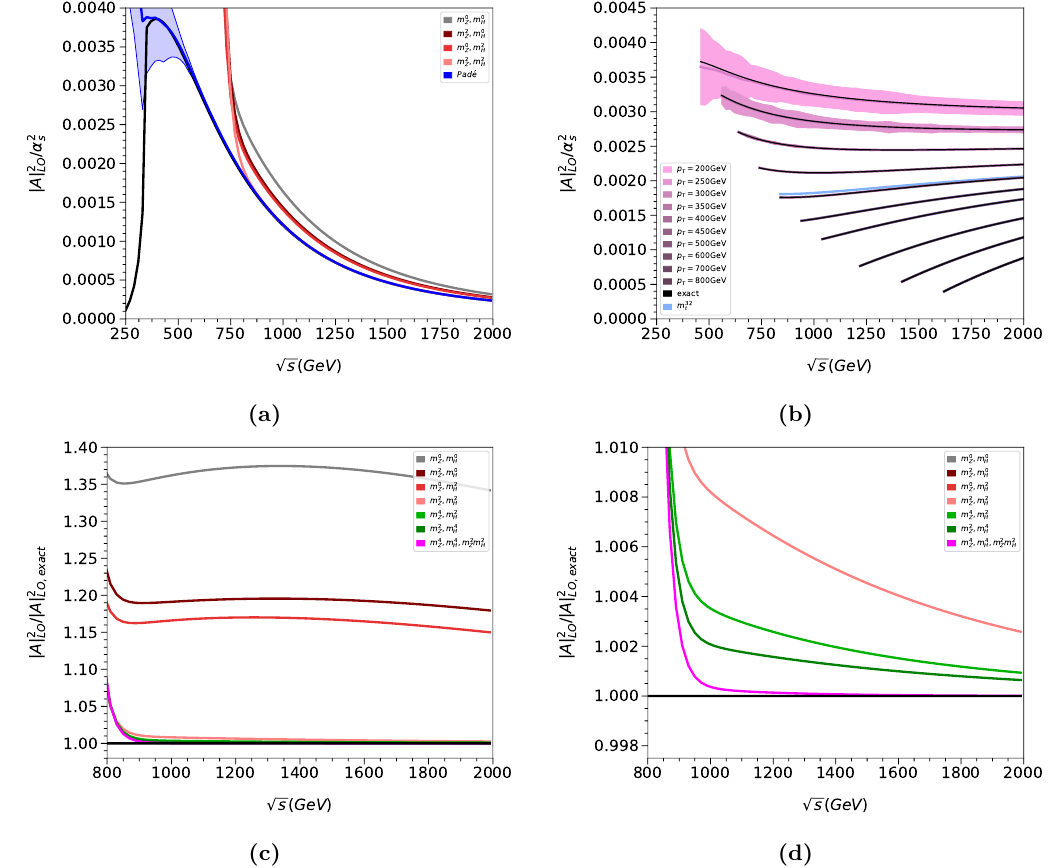
√ Figure 2. (a) LO squared amplitude as a function of s for fixed scattering angle θ = π/ 2 . In (b) we show results for fixed transverse momentum p T . Panel (c) shows the ratio of expansions of (a) to the exact result. Plot (d) is a zoomed-in version of (c). Note that for better readability in (a) no quartic corrections are shown; the black curve in (a) refers to the exact result and the blue curve (and associated uncertainty band) is the result obtained from Padé approximation. In (b) the uncertainty band from the Padé results is only visible for smaller p T